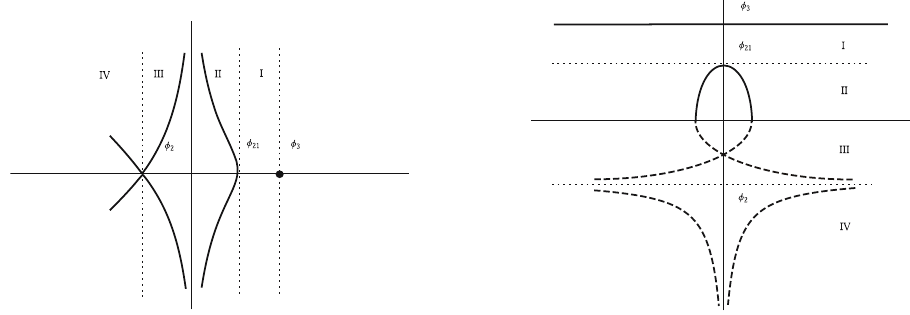
, ϕ and one single root ϕ 3 2